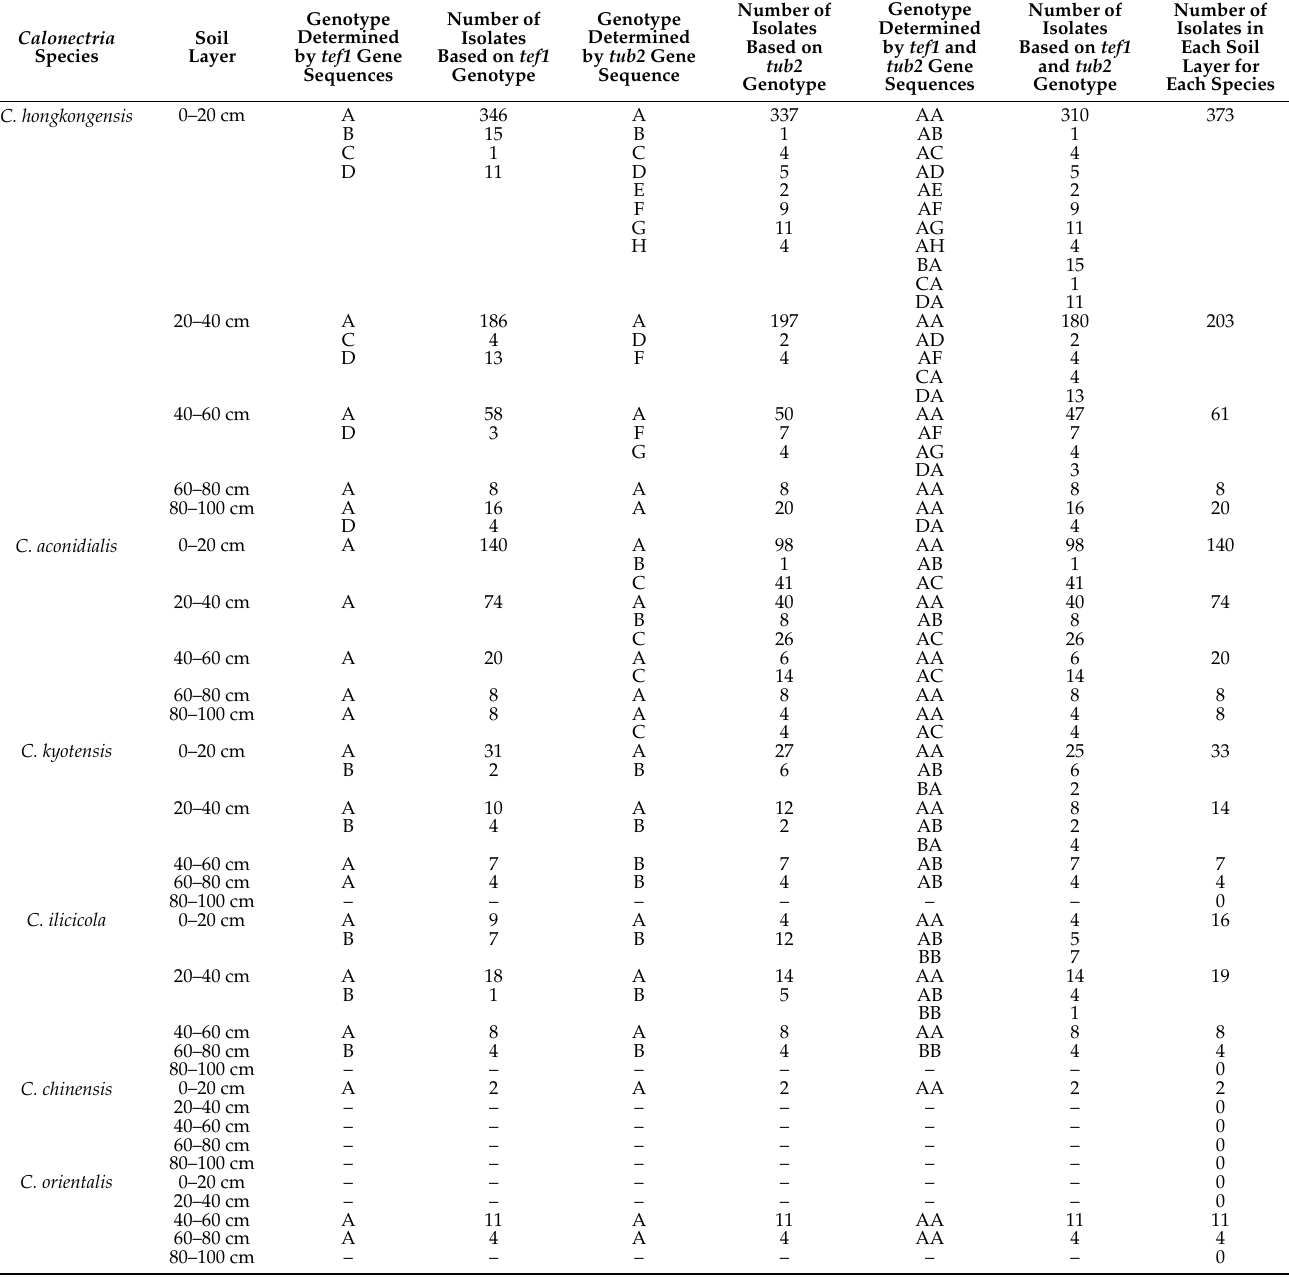
Table 7. Isolate numbers of each genotype in each soil layer for each Calonectria species. Calonectria